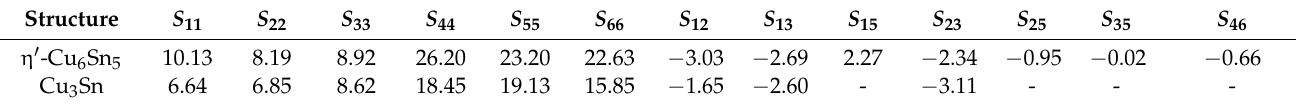
Table 3. The S ij of η (cid:48) -Cu 6 Sn 5 and Cu 3 Sn ( × 10 − 3 , GPa − 1 ).